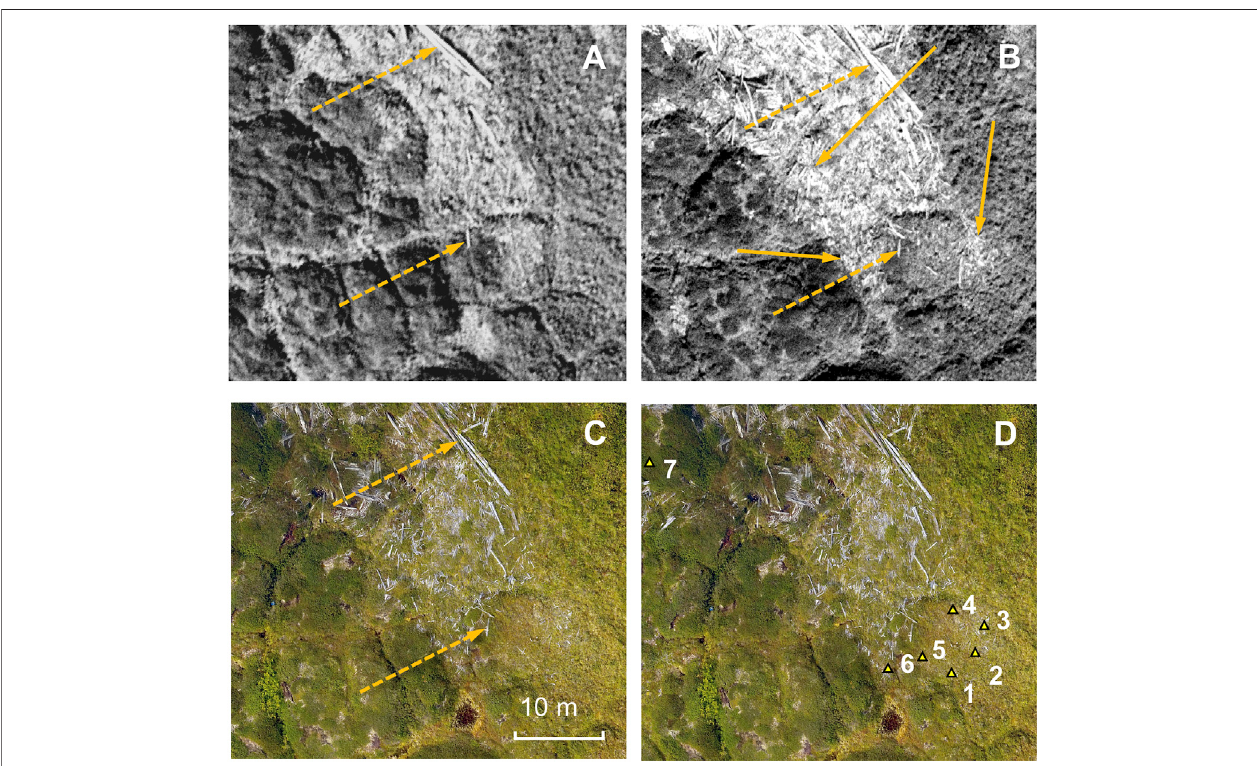
FIGURE 5 | Air photos and orthophoto from (A) 1968, (B) 1972, and (C) 2018 of the upper most driftwood within the Tuktoyaktuk Harbor site show the displacementofwoodbeforeandafterthe1970stormsurge.Thedashedarrows,highlighthowindividualizedpiecesofwoodcanbetrackedmovingupward(downand right in image) through the driftwood accumulation and have remained in place in 2018. Areas of newly deposited driftwood are shown with the solid arrows in the 1972 image. The extent of these fi gures are marked as an orange box in Figure 4 . Figure D displays the location of radiocarbon dating samples taken from the upper most driftwood. Marked locations correspond to samples shown in Table 4